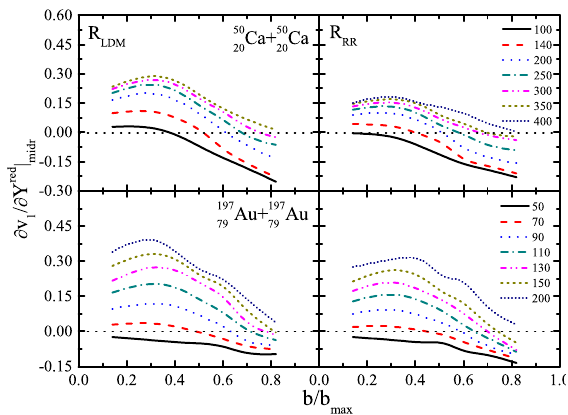
Figure 1. Scaled impact parameter dependence of reduced flow for the reactions of 50 panel) and 197 Au + 197 Au (lower panel) at di ff erent incident energies for two nuclear charge radii pa- 79 79 rameterizations: R LDM (left panels) and R RR (right panels). Di ff erent lines in figure represents di ff erent incident energies in upper and lower